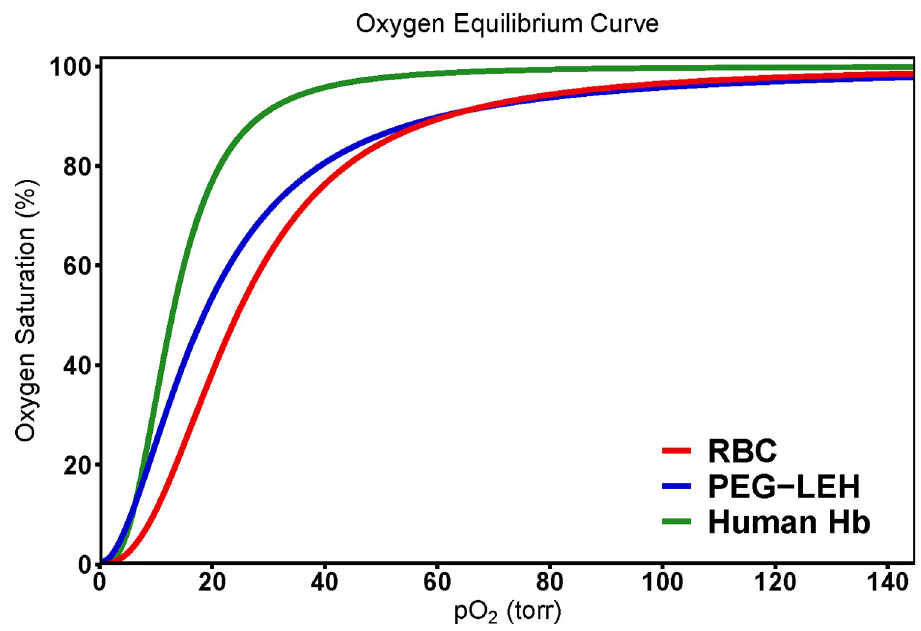
Fig 3. Comparison of O 2 equilibrium curves (OECs) for RBCs, Human Hb and PEG-LEH